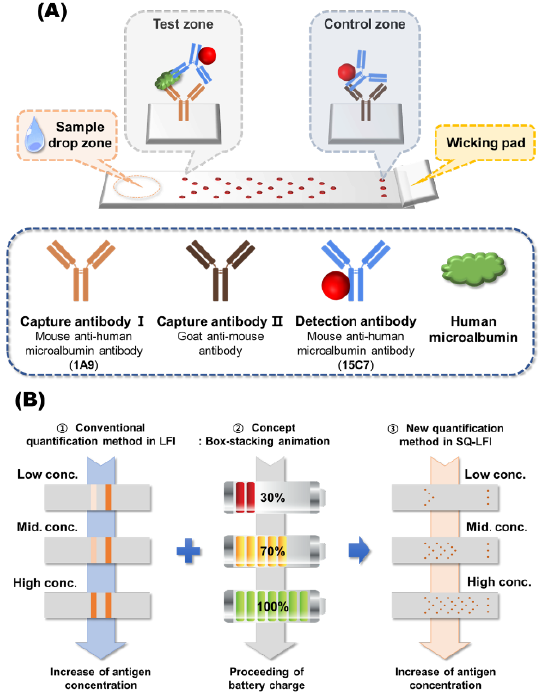
Figure 1. Schematic illustrations of the semi-quantitative lateral flow immunoassay (SQ-LFI) configuration and quantification strategy. ( A ) Configuration of the SQ-LFI system. ( B ) Quantification concepts of the SQ-LFI system.